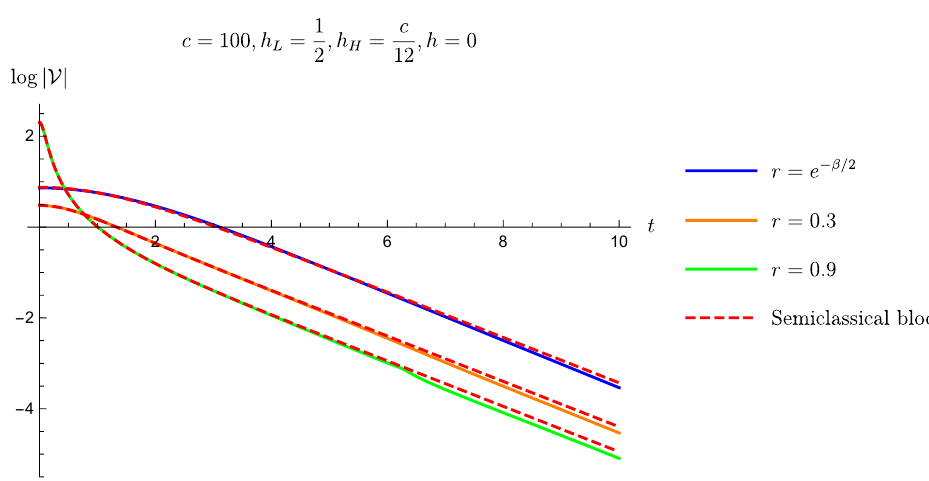
Figure 16 . In this (cid:12)gure we compare the semiclassical and exact blocks associated with ( t + i(cid:12) ). The plot suggests that the semiclassical approximation remains valid for correlators of 2 O ( t + i(cid:12) ). We implement time dependence via z = 1 2 O to a di(cid:11)erent choice of r . Corresponding trajectories in the unit q disk are pictured in (cid:12)gure 6. Apparently the semiclassical approximation works well at t + i(cid:12)